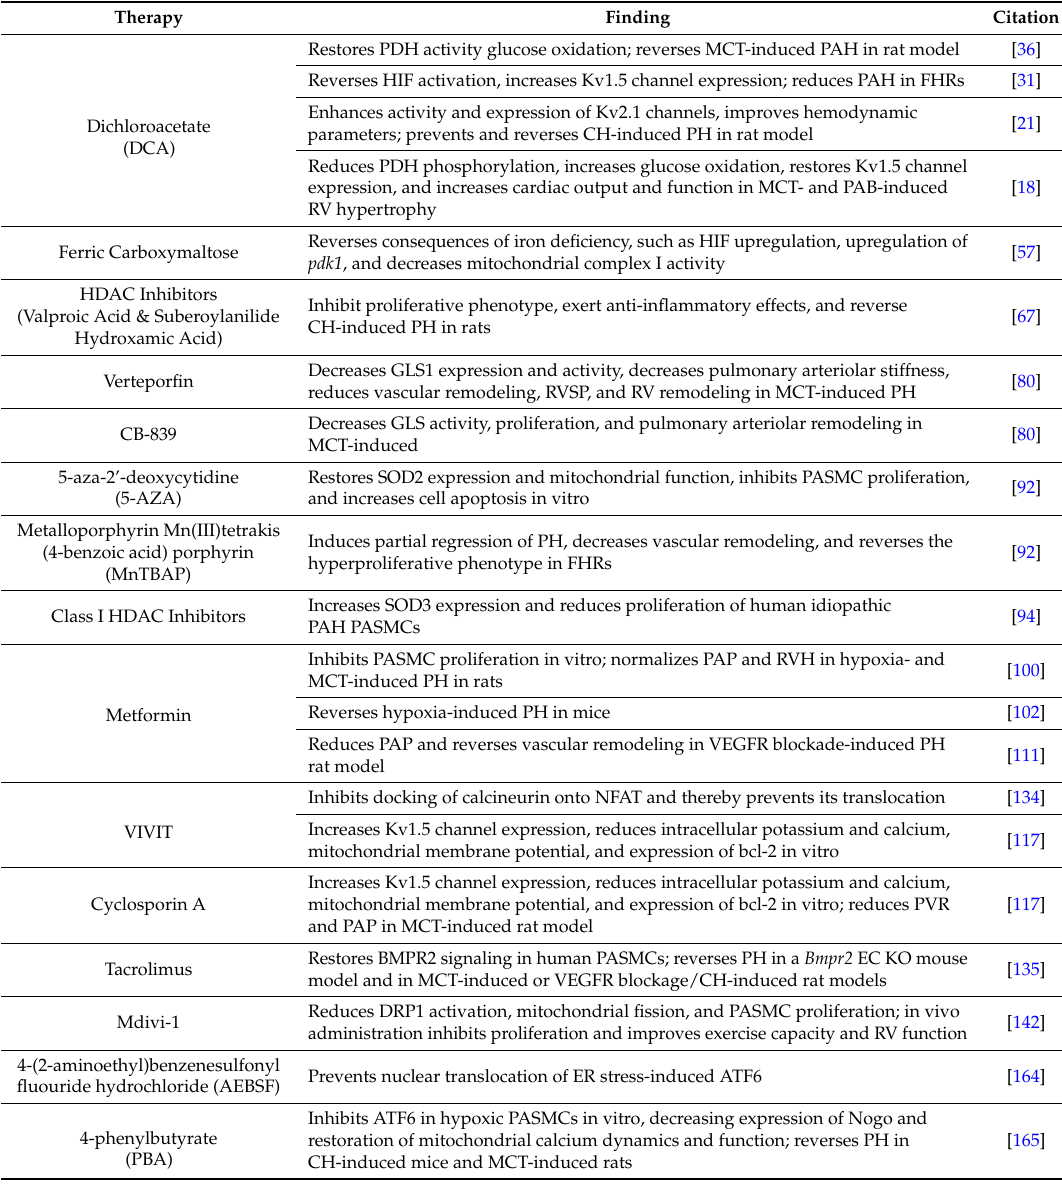
Table 1. Preclinical Interventions in Models of Pulmonary Hypertension. ATF6: activating transcription factor 6. BMPR2: bone morphogenetic protein 2. CH: chronic hypoxia. CO: cardiac output. DRP1: Dynamin-related protein 1. EC: endothelial cell. ER: endoplasmic reticulum. FAO: fatty acid oxidation. FHR: Fawn-Hooded rat. GLS1: glutaminase. HIF: hypoxia-inducible factor. HK1: hexokinase 1.